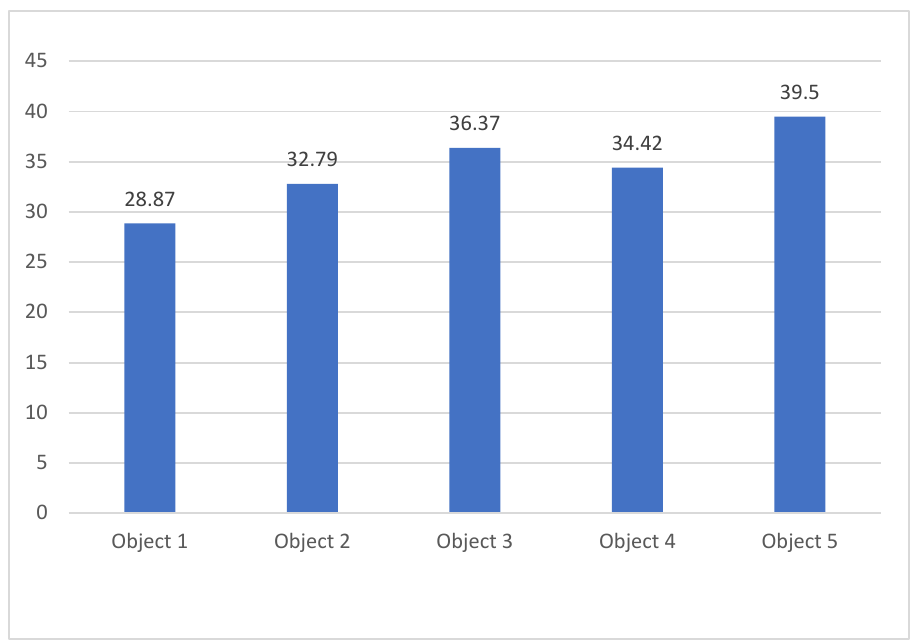
Figure 2. Trade fraction tuber yield t·ha -1 (on average for two cultivars Oberon and Malaga and three study years 2018-2020).